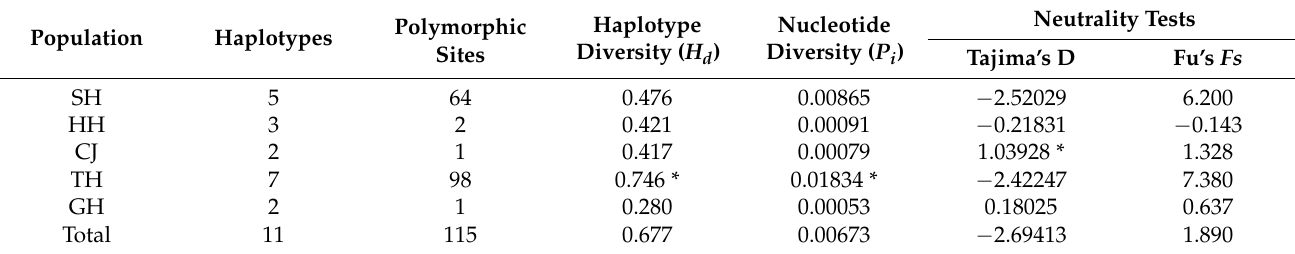
Table 3. Genetic diversity of five populations of C. alburnus based on COI sequences.